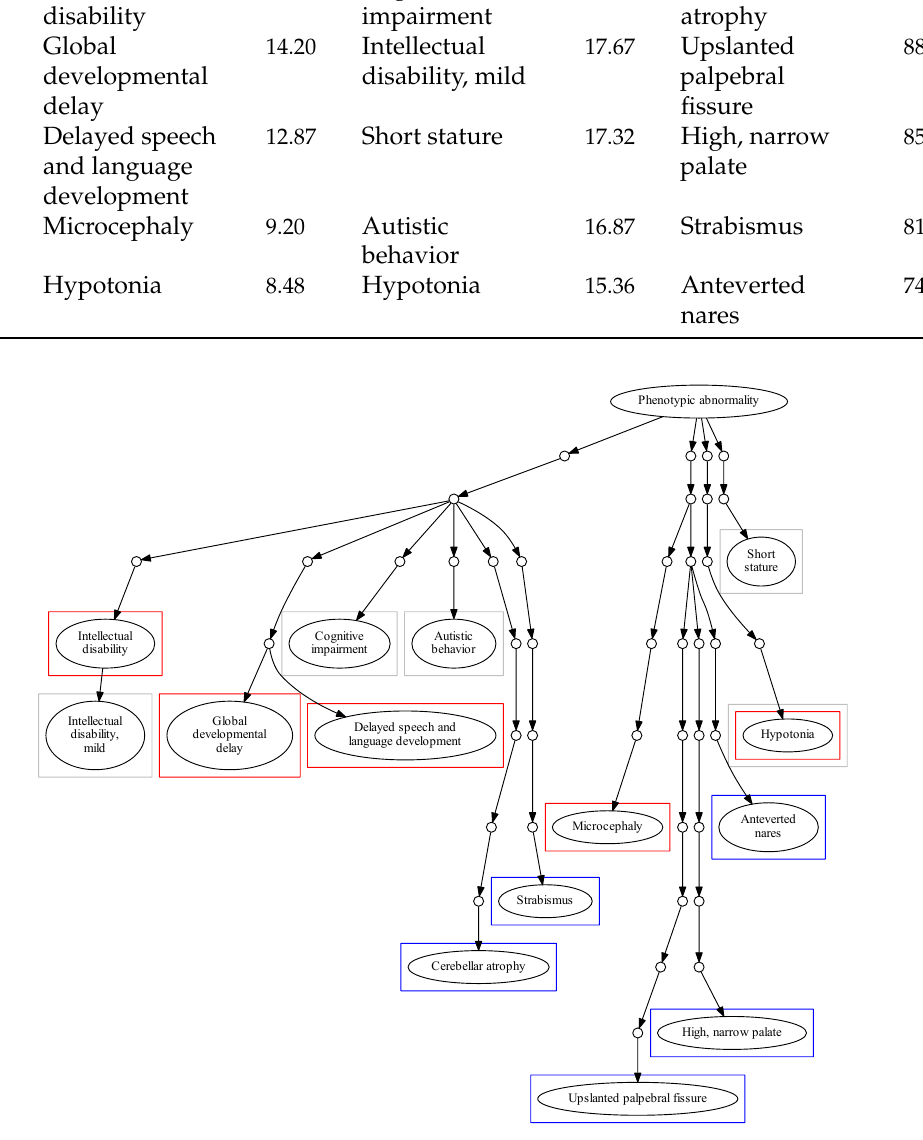
Figure 2. Schematic representation of top five most frequent HPO terms for each cohort in relation to the “Phenotypic abnormality” node. Coloured squares represent terms for each cohort. Red: DECIPHER. Gray: ID/MCA. Blue: